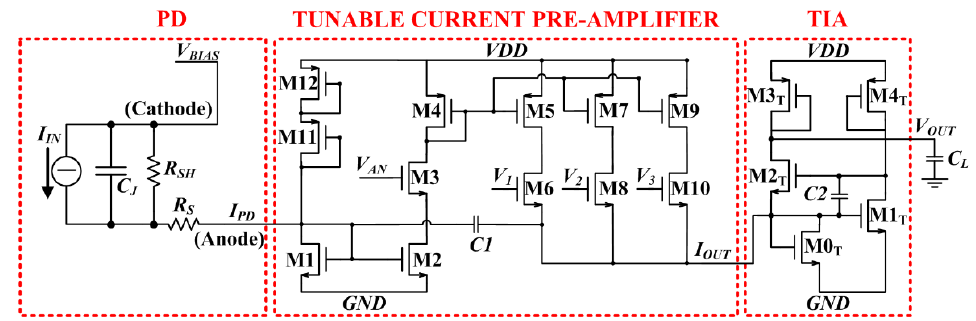
Figure 2. Schematic of the proposed electronic circuit designed at transistor level.